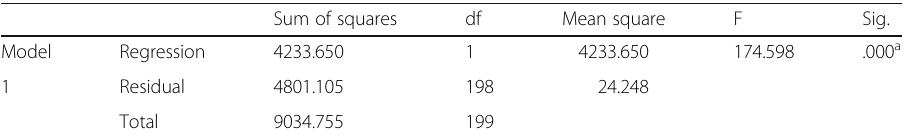
Table 5 ANOVA (for significance of regression model) Sum of squares df Mean square